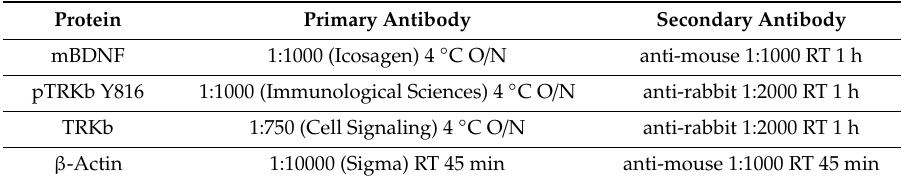
Table 4. Antibodies condition for Western blot